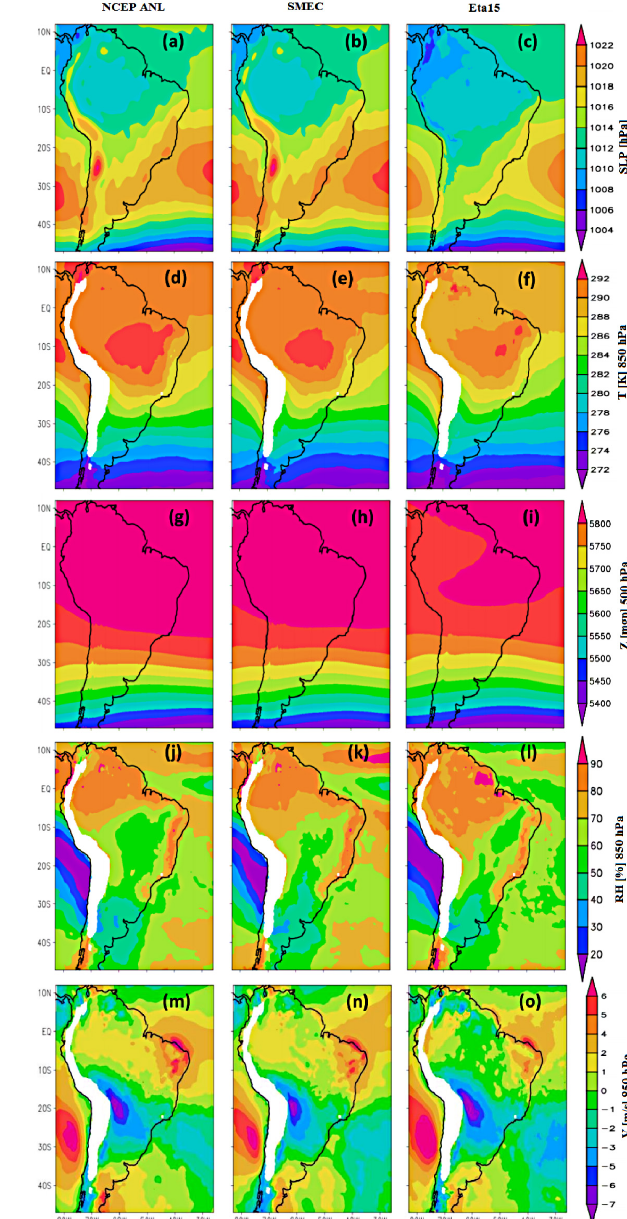
Figure 5. Means for the winter trimester of NCEP analyses (first column), and 168h forecasts from SMEC (second column) and Eta15 (third column) for the variables mean sea level pressure (a, b, c) , 850hPa temperature (d, e, f) , 500hPa geopotential height (g, h, i) , and 850hPa relative humidity (j, k, l) and meridional wind (m, n, o)